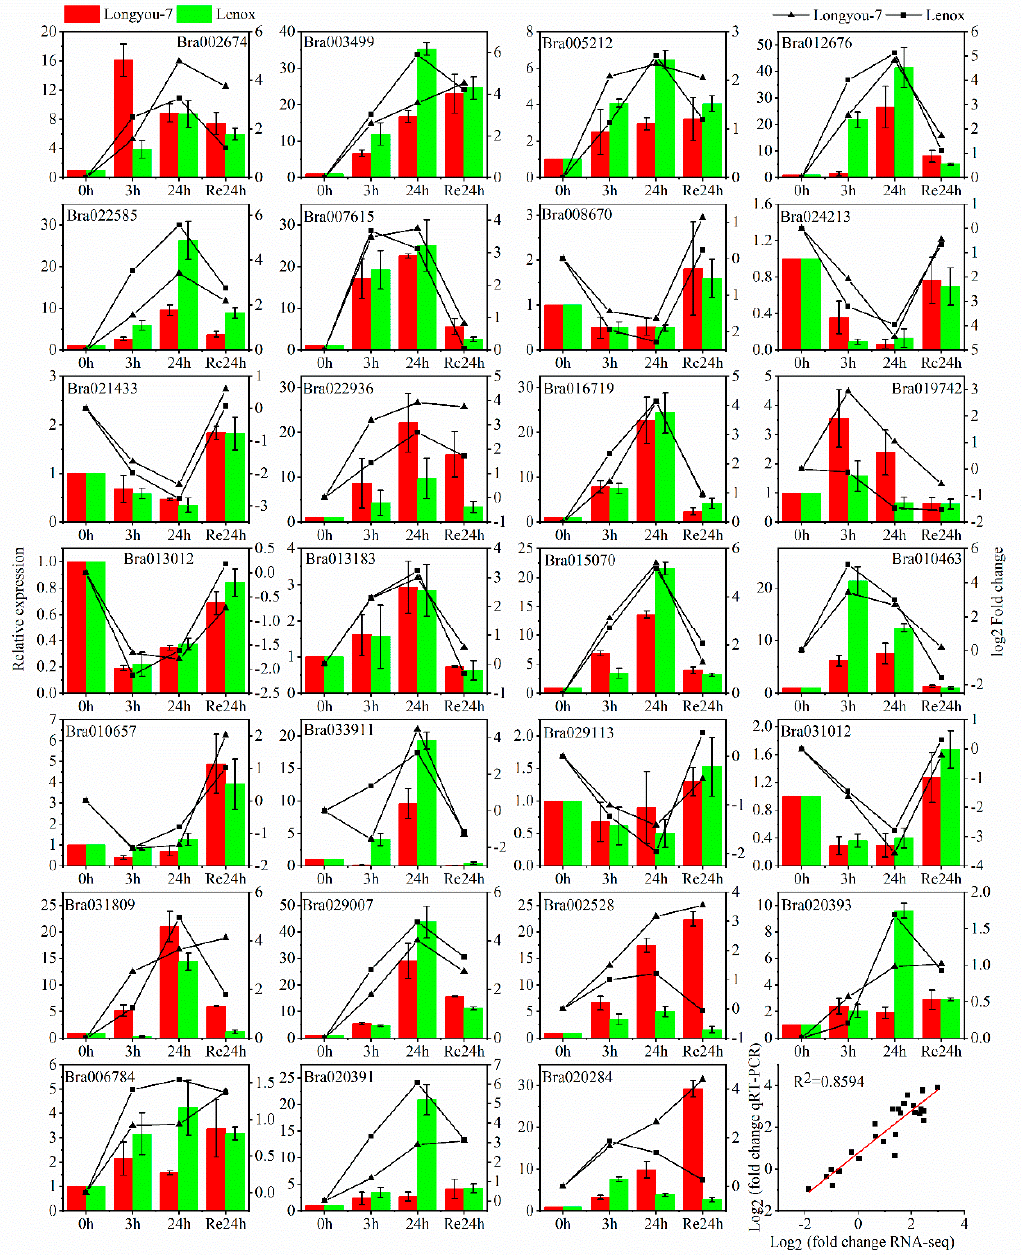
Figure 6. qRT-PCR analysis of 27 cold-induced unigenes during various stages of cold stress. The expression pattern of the selected gene was analyzed by treating at 4 ◦ C for 0, 3, and 24 h and recovery at 22 ◦ C for 24 h. Bars with standard errors represent relative expression levels determined by qPCR from three independent biological replicates using the 2 − ∆∆ CT method (left y -axis). Broken lines indicate transcript abundance change (log2 fold) according to the RPKM value of RNA-Seq (right y -axis). Correlation between qRT-PCR and RNA-seq for select DEGs is also shown.